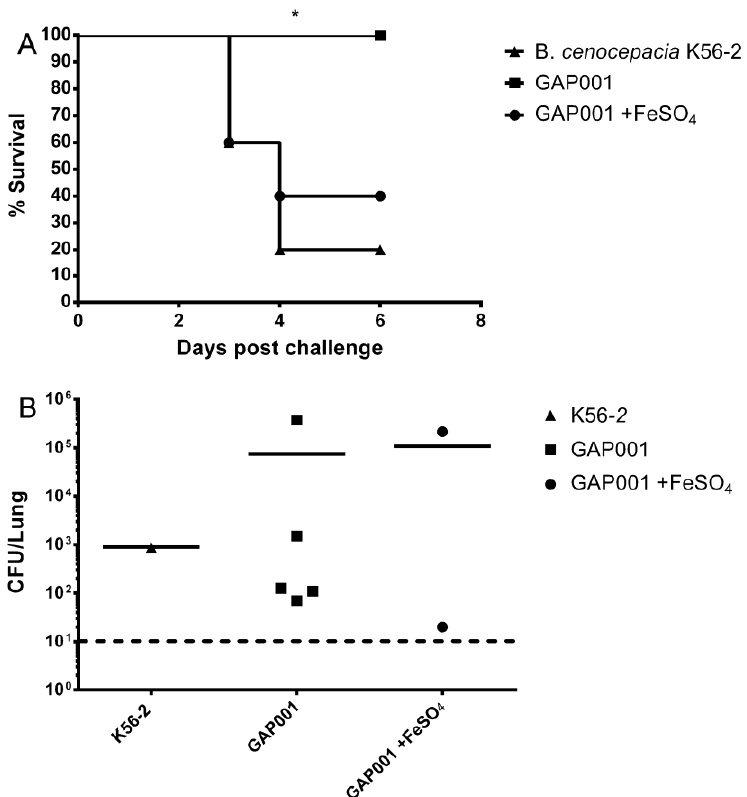
Figure 3. GAP001 is attenuated in BALB/c mice compared to B. cenocepacia. GAP001 was unable to kill BALB/c mice at the same dose as B. cenocepacia . ( A ) Percent survival of BALB/c mice challenged with 5 × 10 7 CFU of GAP001 grown in LB (squares) or LB with 200 μM FeSO 4 (circles) and B. cenocepacia K56-2 (triangles). ( B ) Bacterial counts in mice lungs for mice infected with GAP001 grown in LB (squares) or LB with 200 μM FeSO 4 (circles) and B. cenocepacia K56-2 (triangles). Bacterial counts were determined 6 days post infection. The limit of detection was 10 CFU/lung (horizontal dotted line). The Kaplan–Meier method was used and significant differences ( p ≤ 0.5) were calculated via a log rank test.